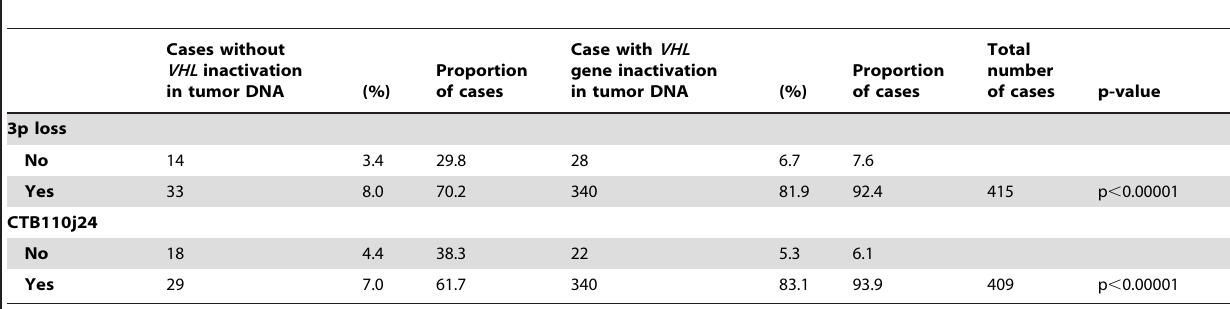
Table 3. Cases with/without VHL genetic or epigenetic inactivation and chromosome 3p and VHL locus loss (clone CTB-110j24) using array